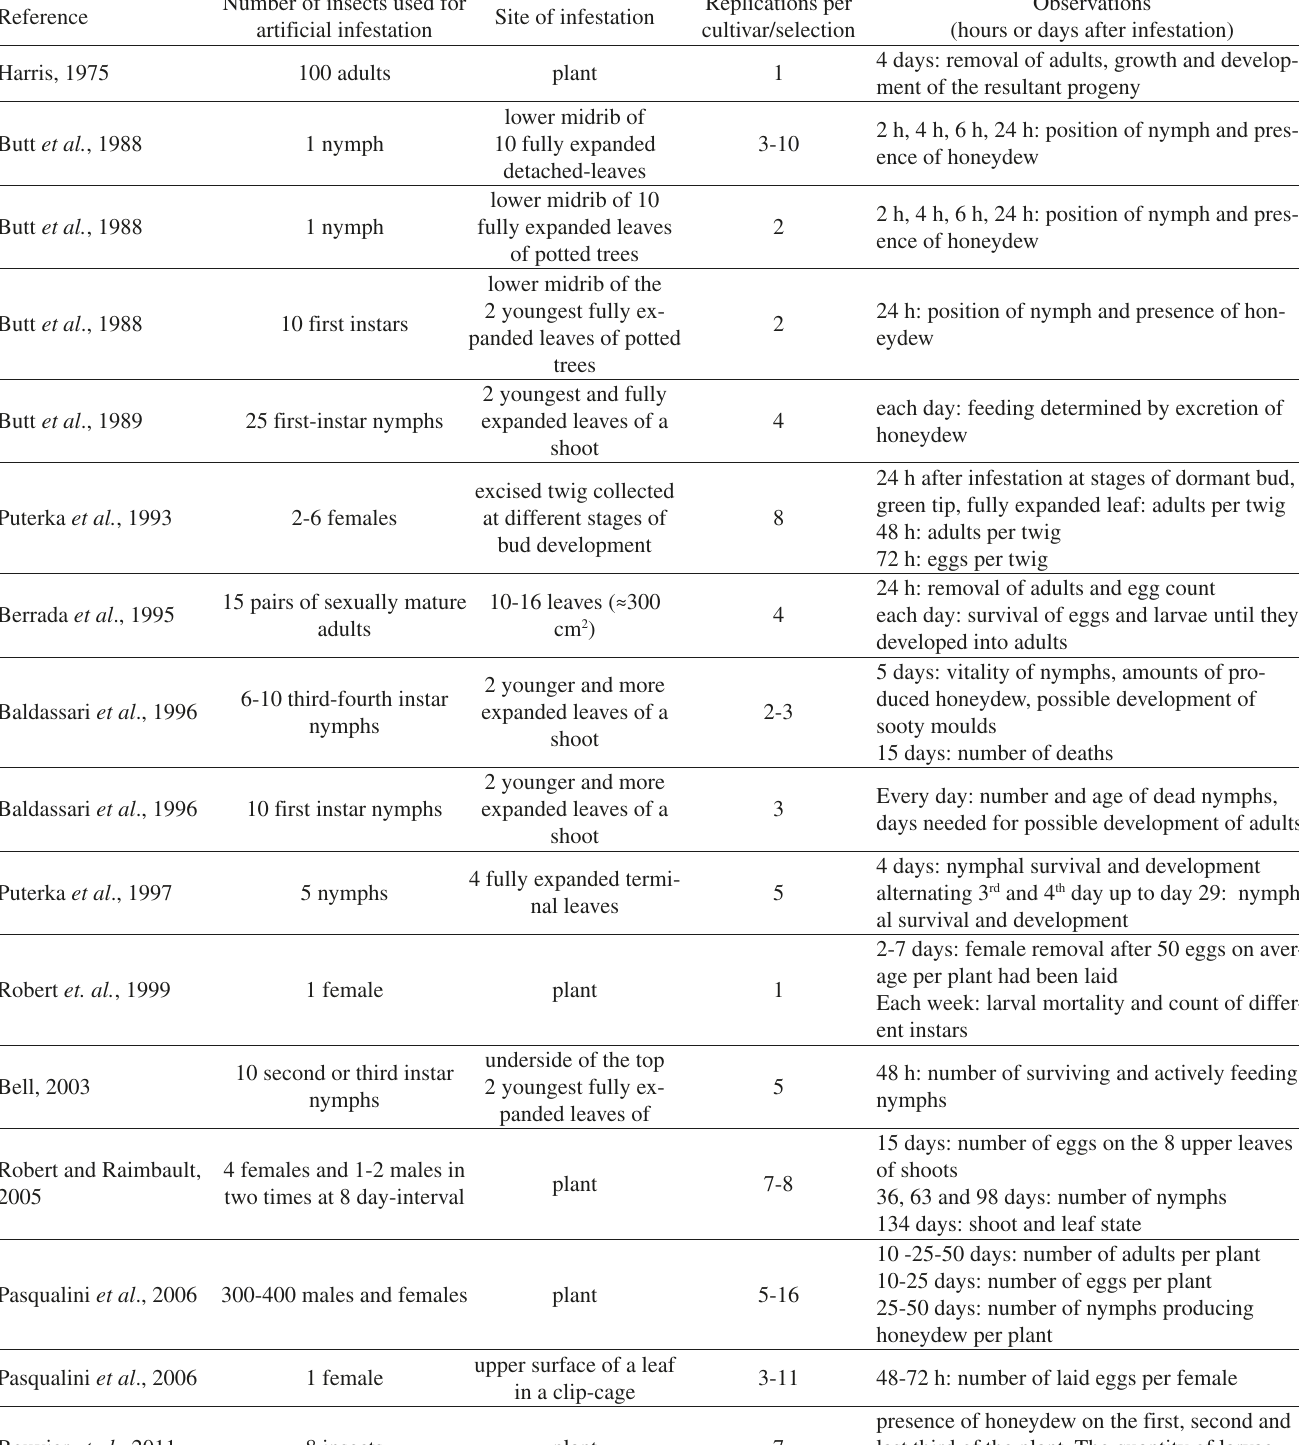
Table 3 - Pear resistance to psylla: assay methods adopted in controlled conditions